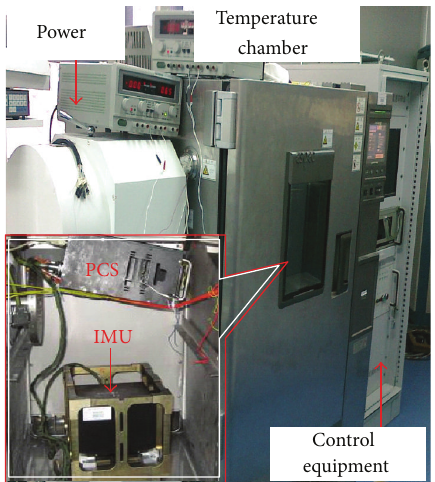
Figure 5: The equipment of the temperature experiment.